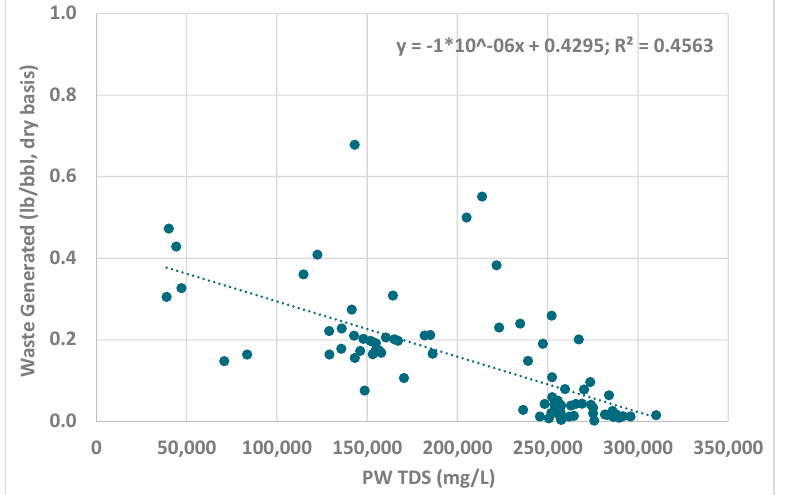
Figure 4. Estimated solid waste generated (lb/bbl) via MLD as a function of PW TDS.